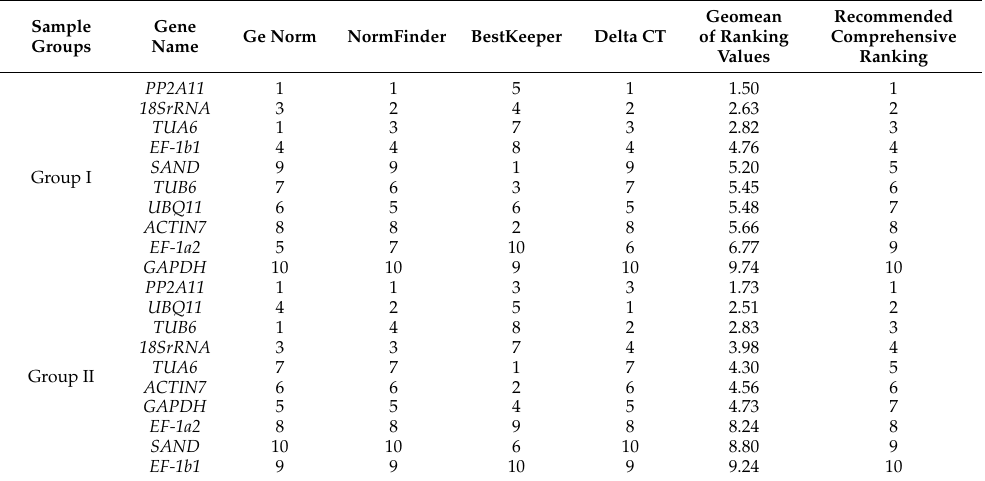
Table 4. Comprehensive ranking of internal RGs